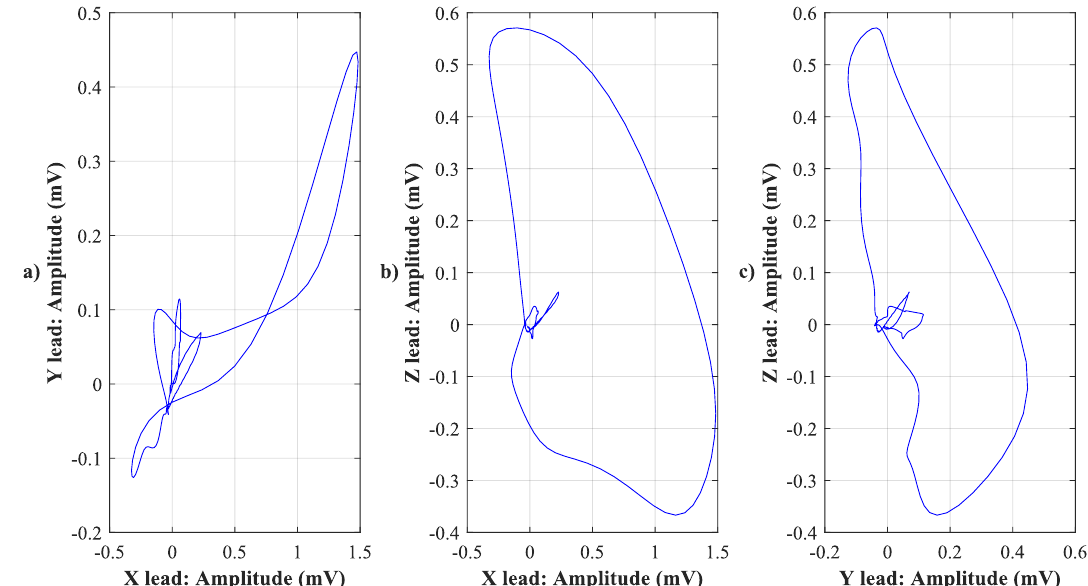
Figure 2. 2-D image using three VCG planes. ( a ) X lead to Y lead, ( b ) X lead to Z lead, and ( c ) Y lead to Z lead.